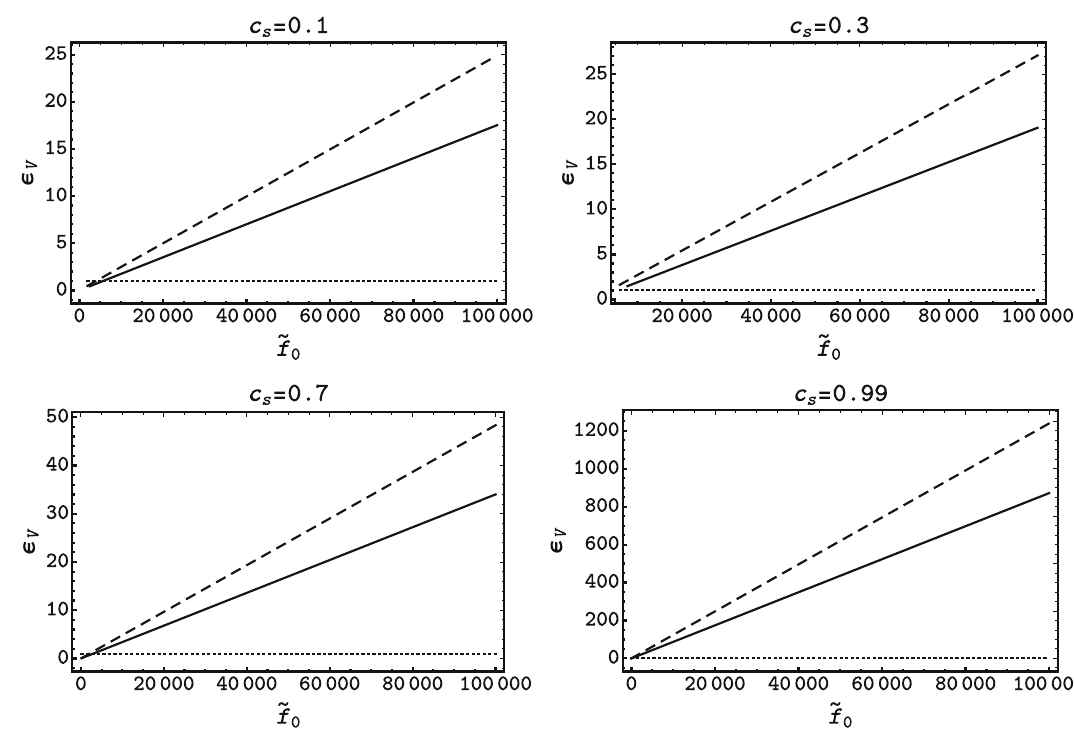
Fig. 8 The potential slow-roll parameter (cid:10) V versus ˜ f 0 for different sound speeds c s = ( 0 . 1 , 0 . 3 , 0 . 7 , 0 . 99 ) . The dashed and solid lines are related to N ∗ = 50 and 60,